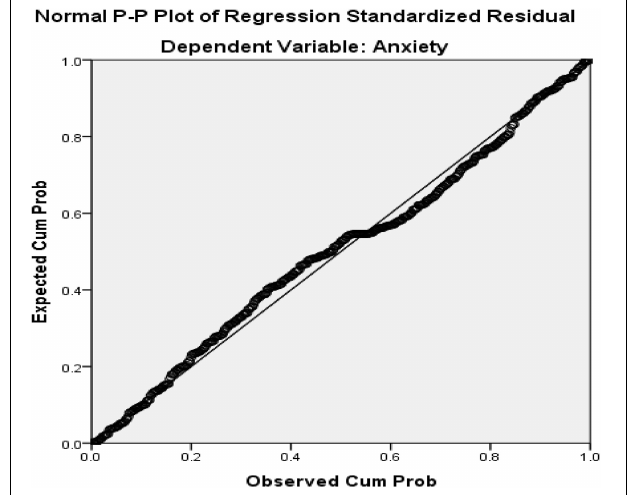
FIGURE 4 | Normal Probability Plot (p-p) of the regression standardized